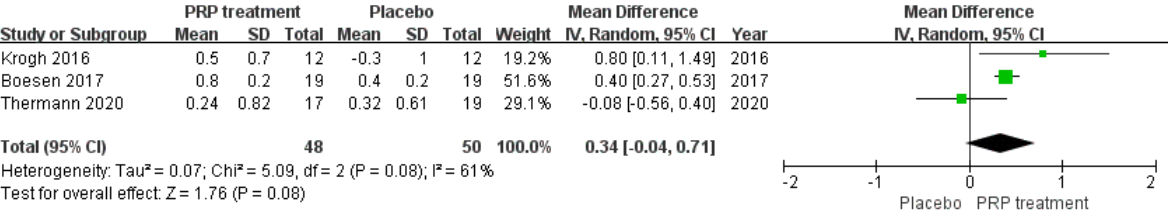
Figure 5. Forest plot of change values for the Victorian College Ankle Function Scale scores. Changes in Achilles Tendon Thickness